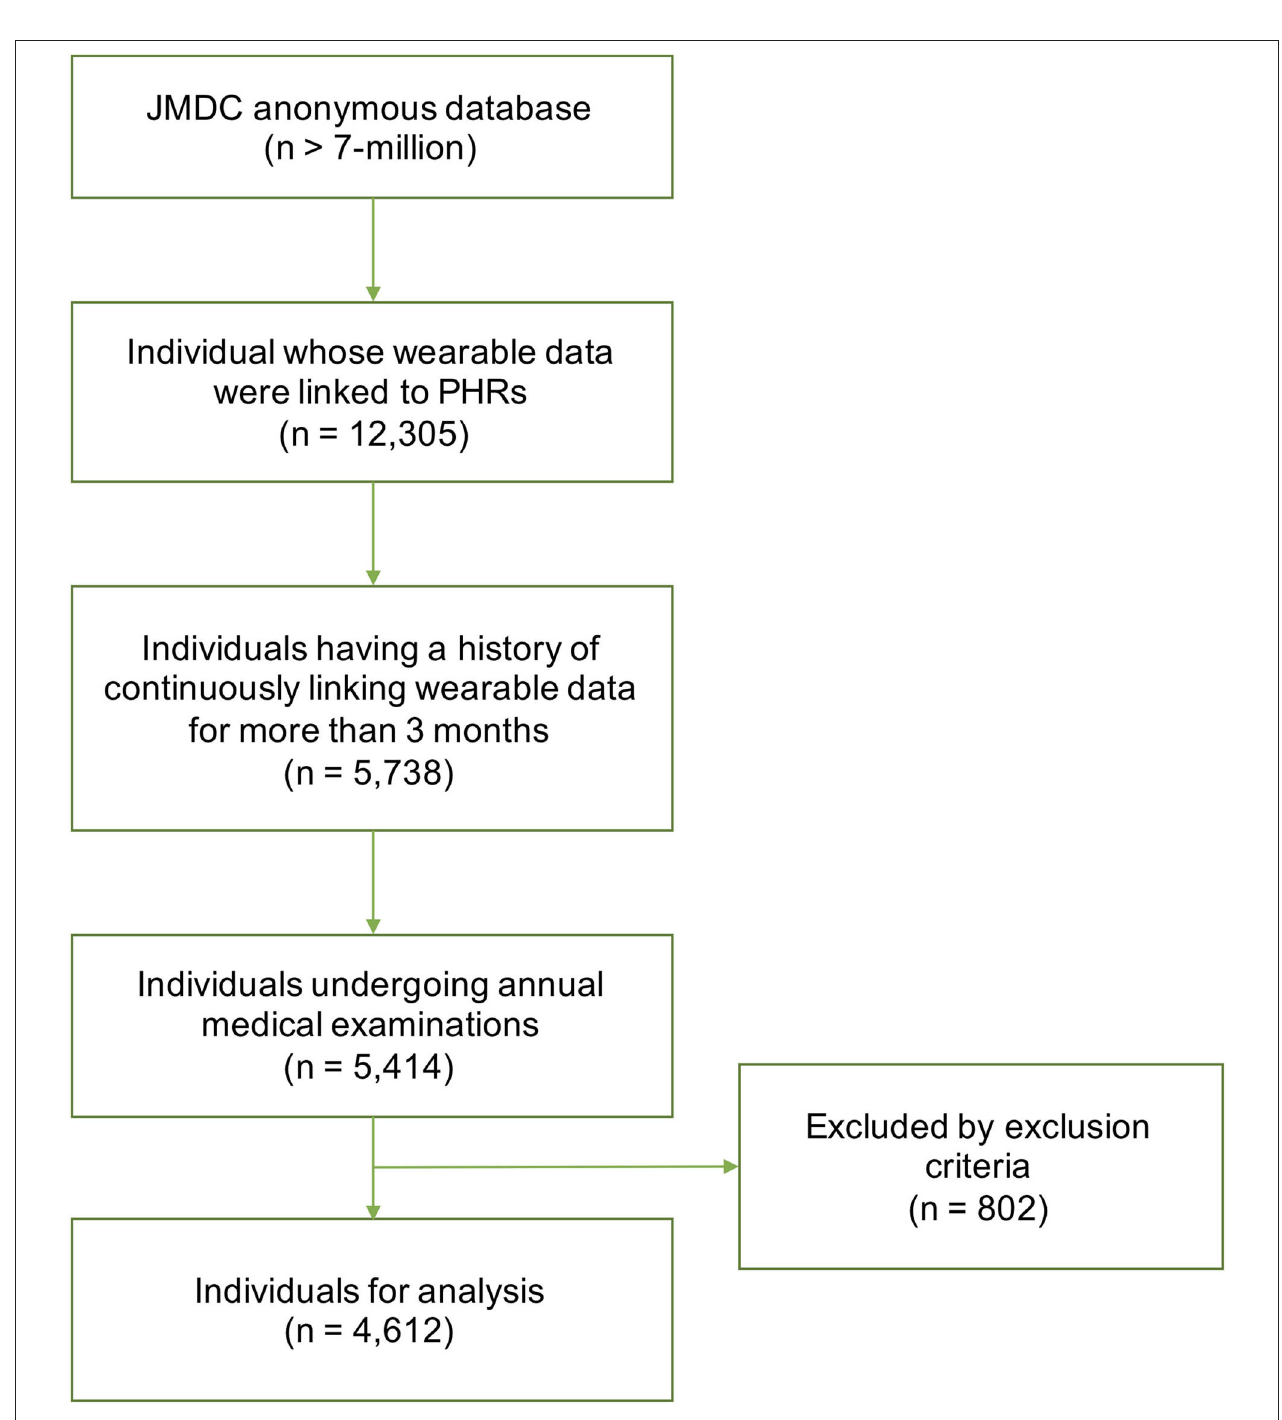
FIGURE 2 | Flow diagram detailing subject inclusion. PHRs, personal health